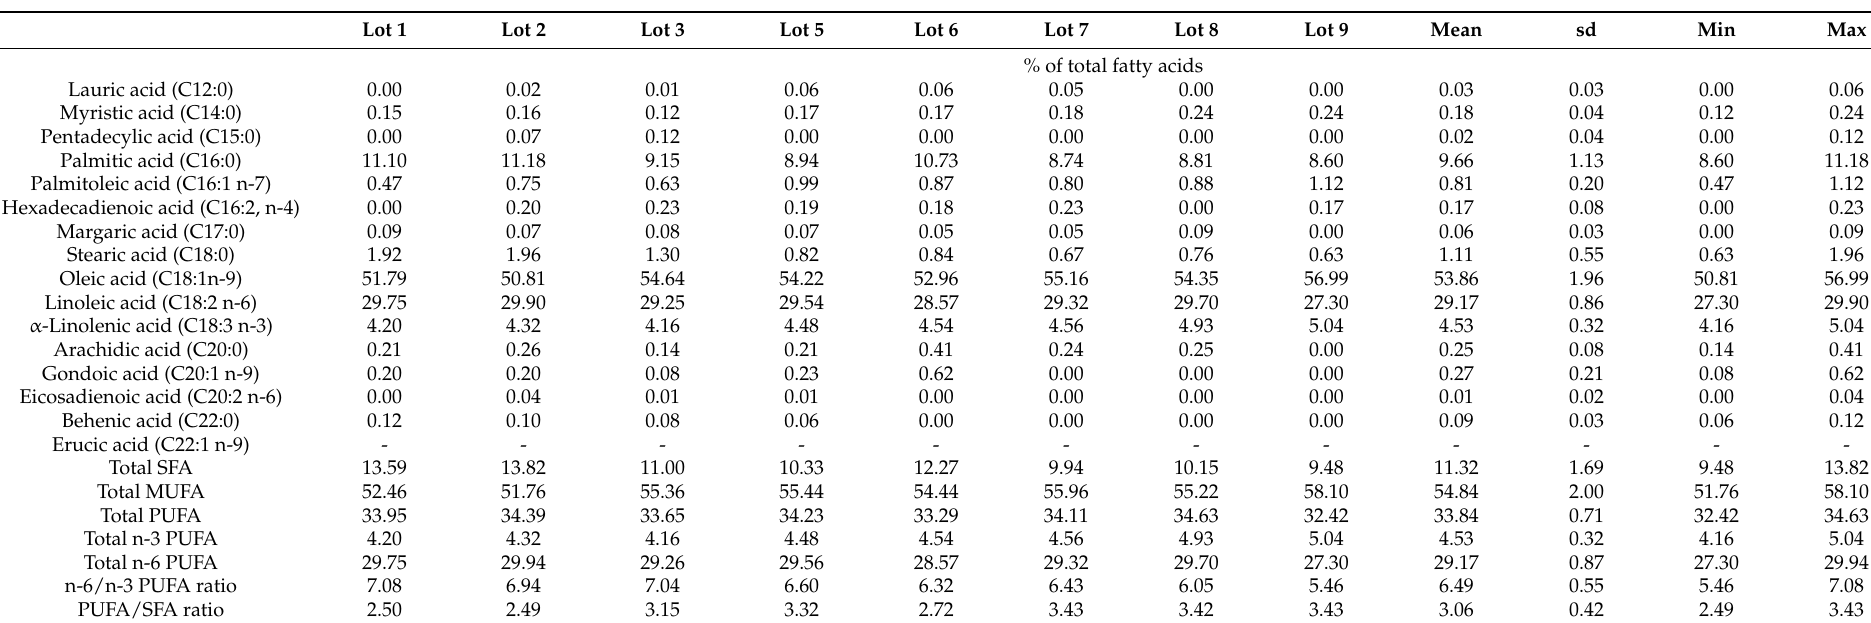
Table 4. Fatty acid profile of rapeseed meal samples. Mean, standard deviation, and range of values obtained from different lots collected between July 2018 and July 2019 ( n = 8)